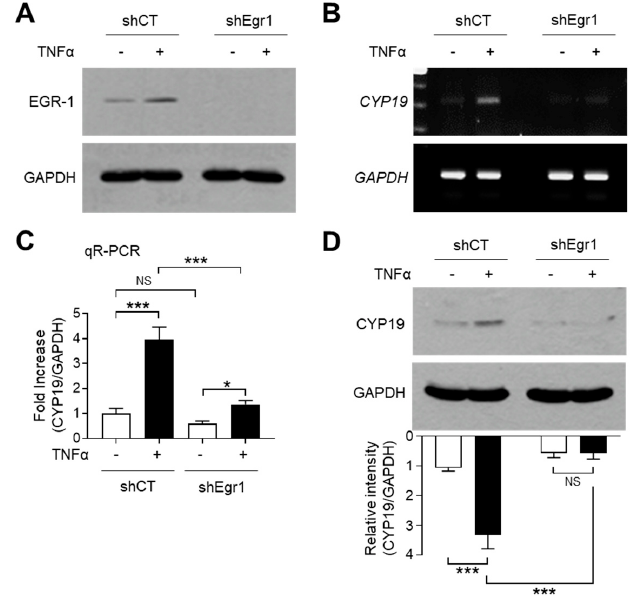
Figure 3. Effect of EGR-1 silencing on CYP19 expression. ( A ) EGR-1 expression in stably transfected MCF-7 cells expressing scrambled control (shCT) or EGR1 short-hairpin RNA (shEgr1) was verified by immunoblotting. Exponentially growing MCF-7 variant cells were cultured in the presence or absence of 10 ng/mL TNF α for 1 h. The cells were then harvested and analyzed by immunoblotting using anti-EGR-1 antibody. GAPDH was used as an internal control. (B–D) MCF-7 cells expressing shCT or shEgr1 were treated with 10 ng/mL TNF α for 24 h. CYP19 mRNA levels were determined by RT-PCR ( B ) and qR-PCR ( C ). GAPDH mRNA levels were used as an internal control. CYP19 aromatase levels were measured by immunoblot analysis ( D ). GAPDH levels were used as an internal control. Band intensities were measured using the ImageJ software. Bars represent the mean ± SD ( n = 3). * p < 0.05, *** p < 0.001 by Dunnett’s multiple comparisons test. NS, not significant; qR-PCR, quantitative real-time